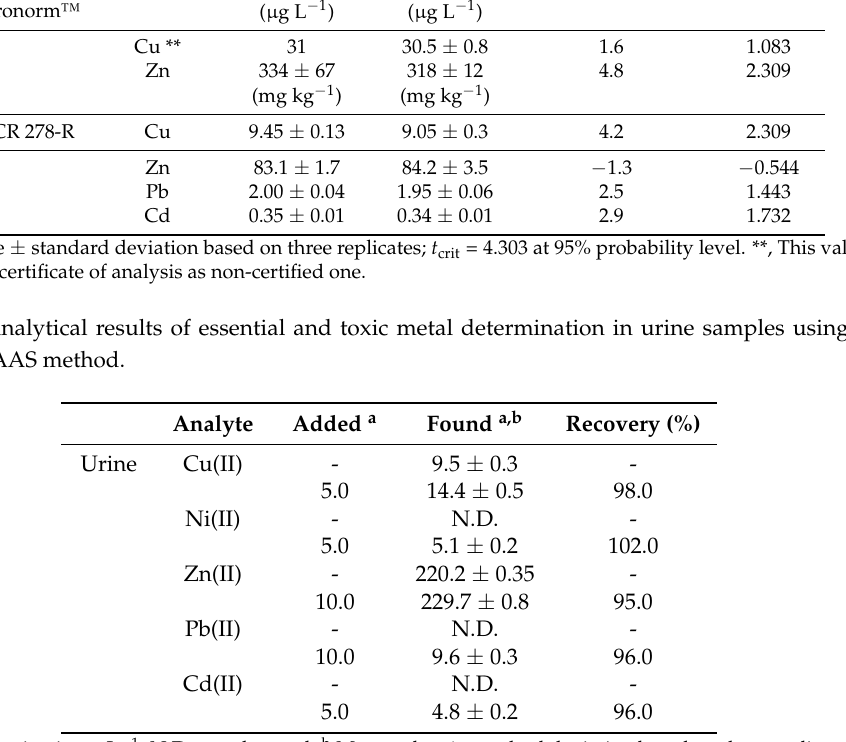
Table S1: Comparative analytical performance characteristics of the proposed FI-FDSE-FAAS method with other selected on–line SPE-FAAS methods for metal